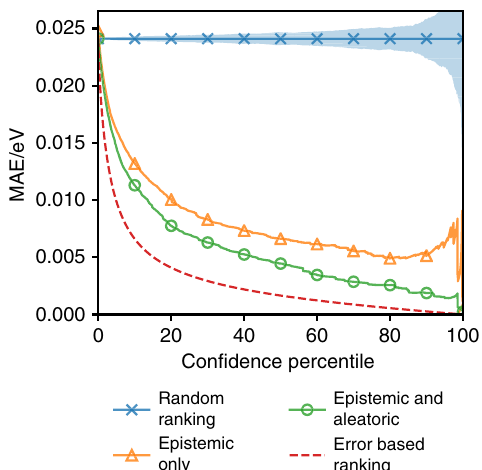
Fig. 3 Con fi dence-error curves on OQMD. The fi gure shows con fi dence- error curves on the OQMD test set. The curves show how the average model error changes as the data points the model is most uncertain about are removed sequentially. The random ranking-based curve in blue serves as a reference showing the result if all points are treated as having equal con fi dence, the blue shaded area highlights the curve ’ s standard deviation computed over 500 random trials.